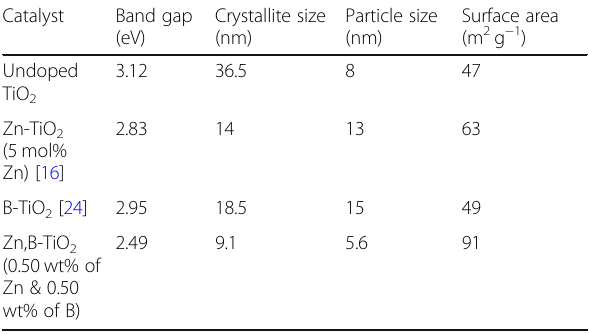
Table 2 Results of band gap (UV-Vis-DRS), crystallite size (XRD), particle size (TEM) and BET surface area Catalyst